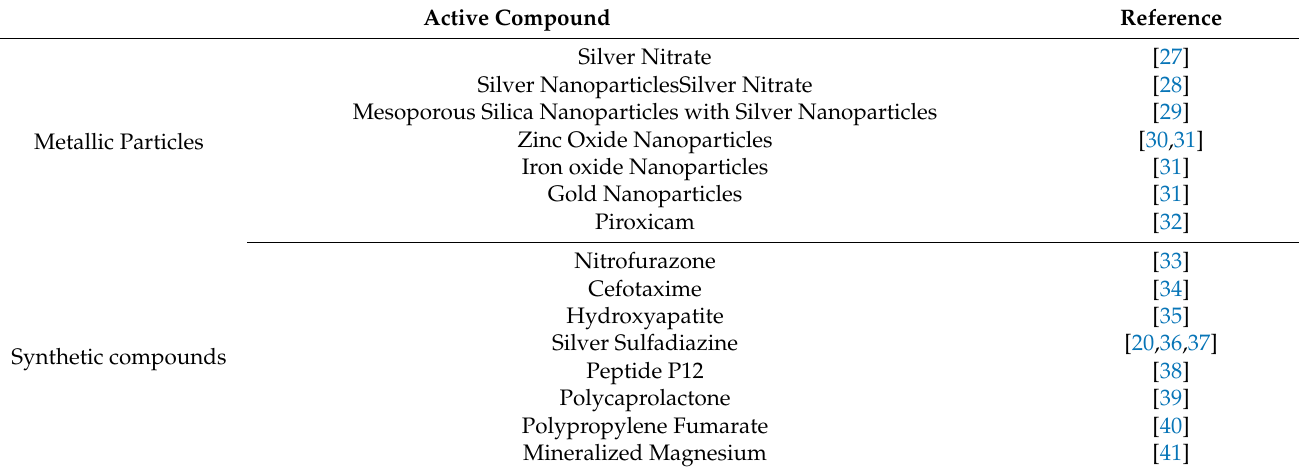
Table 1. Synthetic bioactive and/or non-biological compounds reported in the